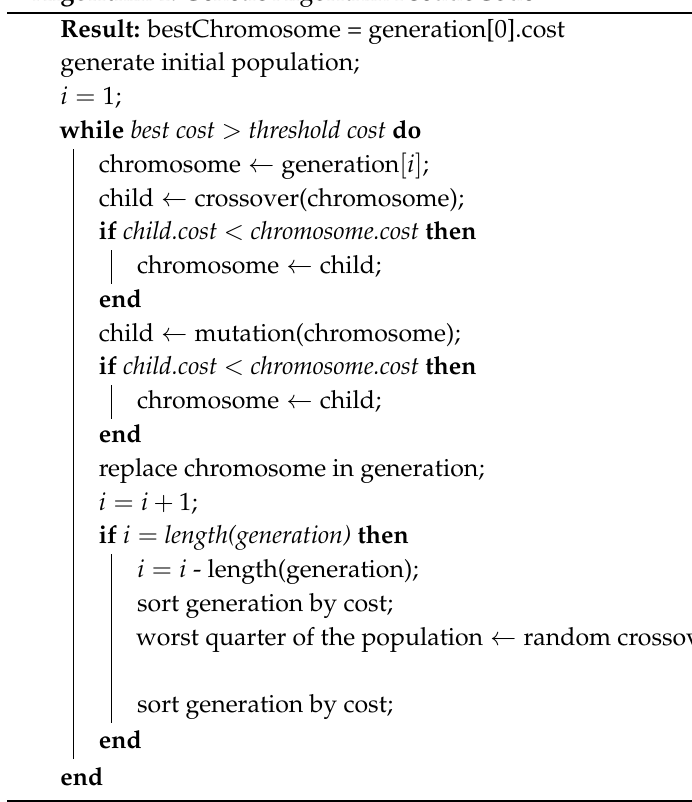
Algorithm 1: Genetic Algorithm